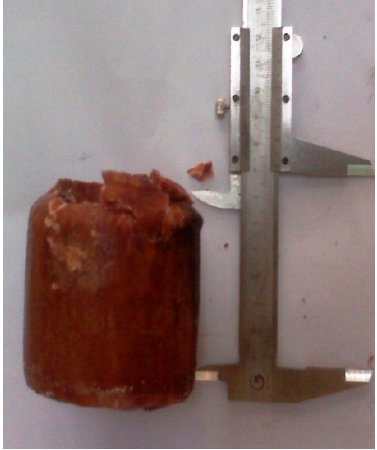
Figure 7. Picture of the molten salt after reacting for 11 h.